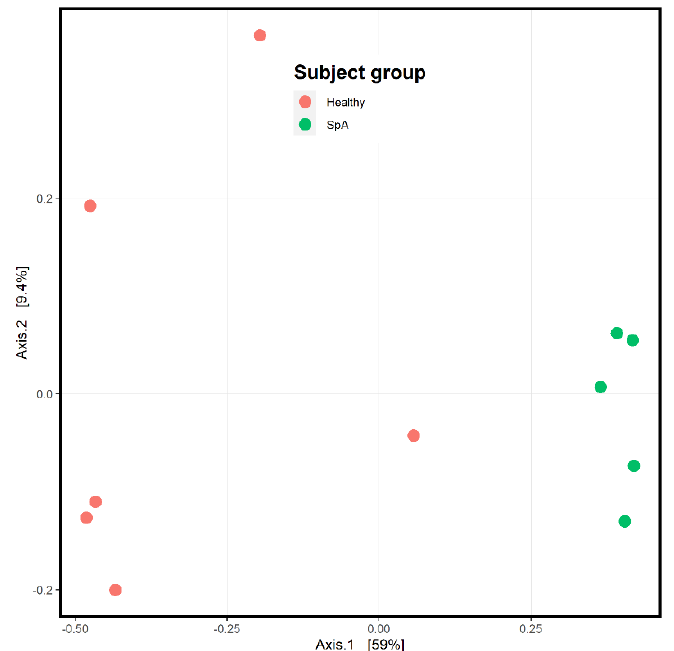
Figure 4. Ordination analysis of sub-gingival samples obtained from healthy control subjects and children with Spondyloarthritis (SpA). The SpA subjects are the green circles, while the controls are depicted in red.